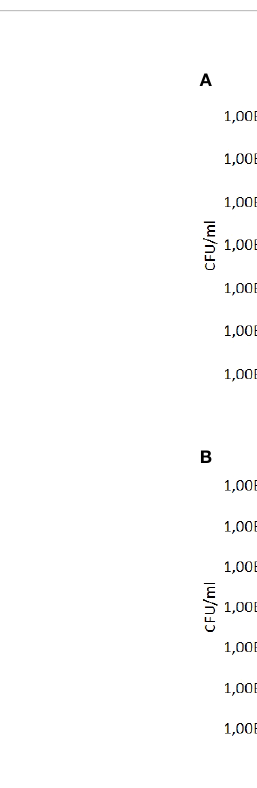
(Figure 6) in the chicken stomach and intestine after termination (terminations no. 1, 2, 3, and 4, were performed at days 6, 21, 28, and 35 of the experiment, respectively). Again, these phages could be detected for several days after eliminating their host from the environment (the lumen of the gastrointestinal tract).